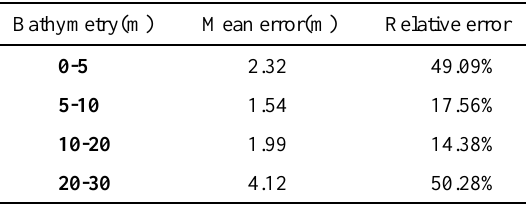
Table 2 Accuracies of semi-analytical bathymetry inversion model Bathymetry(m)